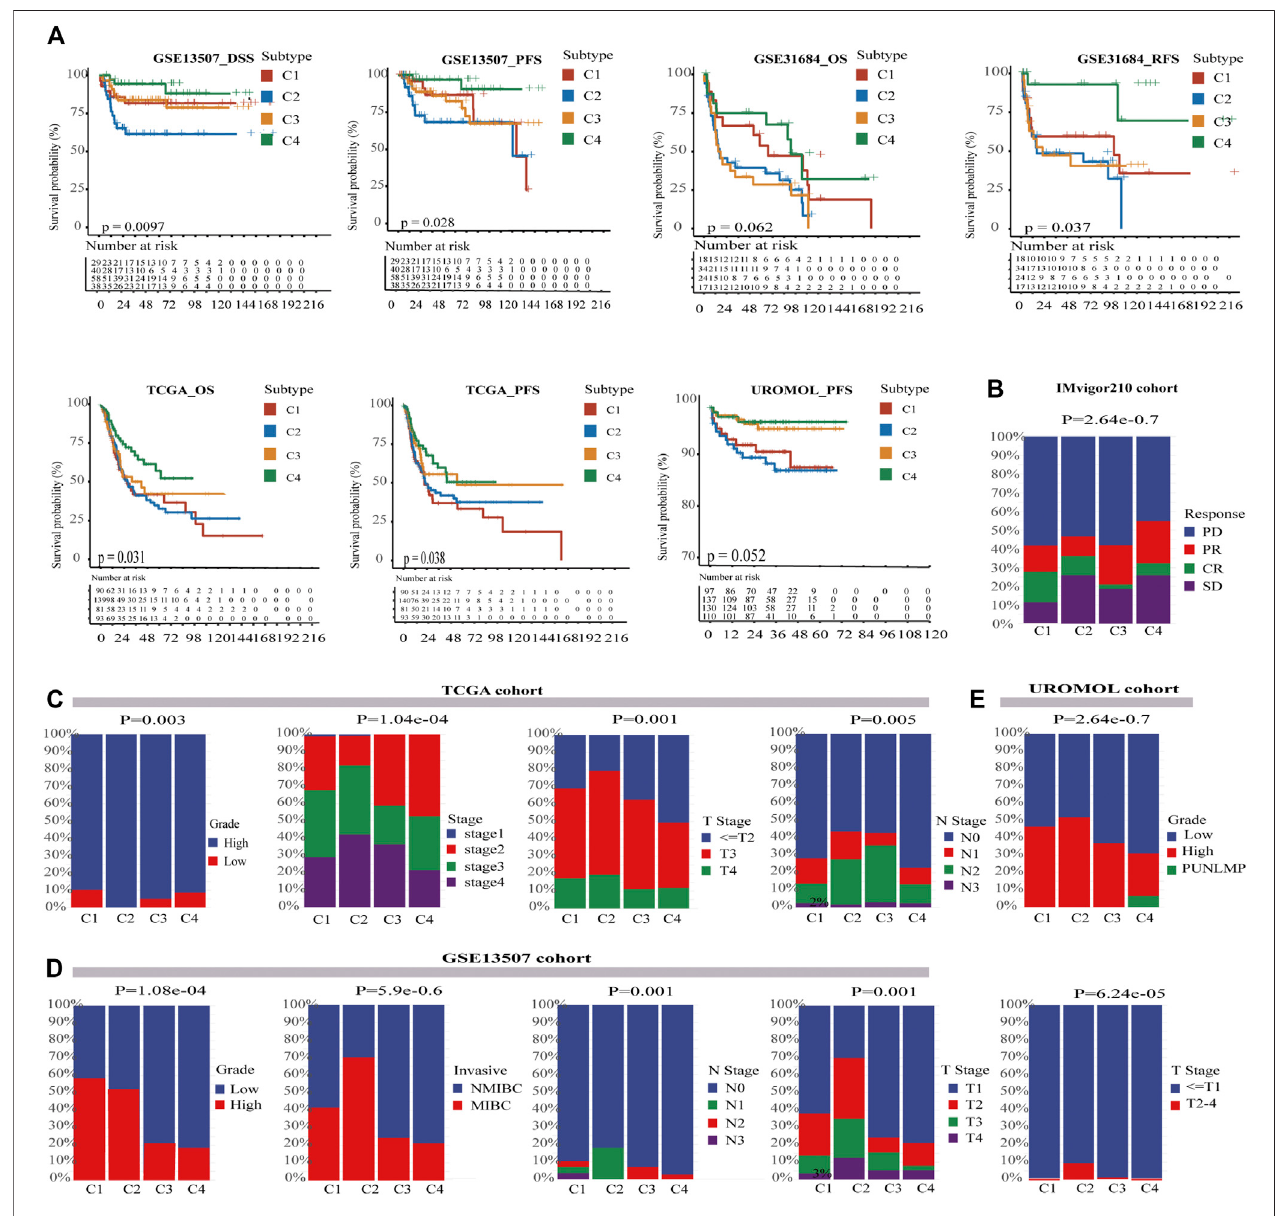
FIGURE 3 | Characterization of clinical features in four subtypes. (A) Kaplan – Meier curves show four subtypes had survival differences in multiple cohorts, and C4 had the best prognosis while C2 has the worst prognosis. The log-rank test p values are shown. (B) The strati fi ed bar chart shows the immune response rates for four subtypes; C1 and C4 both had the highest response rate (30%), and C2 had the lowest immune response rate (20%). C3 had the median immune response rate (23%) (chi-square test, p < .05). (C) In the TCGA-BLCA cohort, the clinical characteristics of C4 were more favorable for survival, whereas C2 was the opposite. C2 had most advanced tumors and most lymph node metastasis (chi-square test, p < .05). (D) In the GSE13507 cohort, the clinical characteristics of C4 were also more favorable for survival, whereas C2 was the opposite (chi-square test, p < .05). (E) In the UROMOL cohort, C4 also had better clinical characteristics than C2